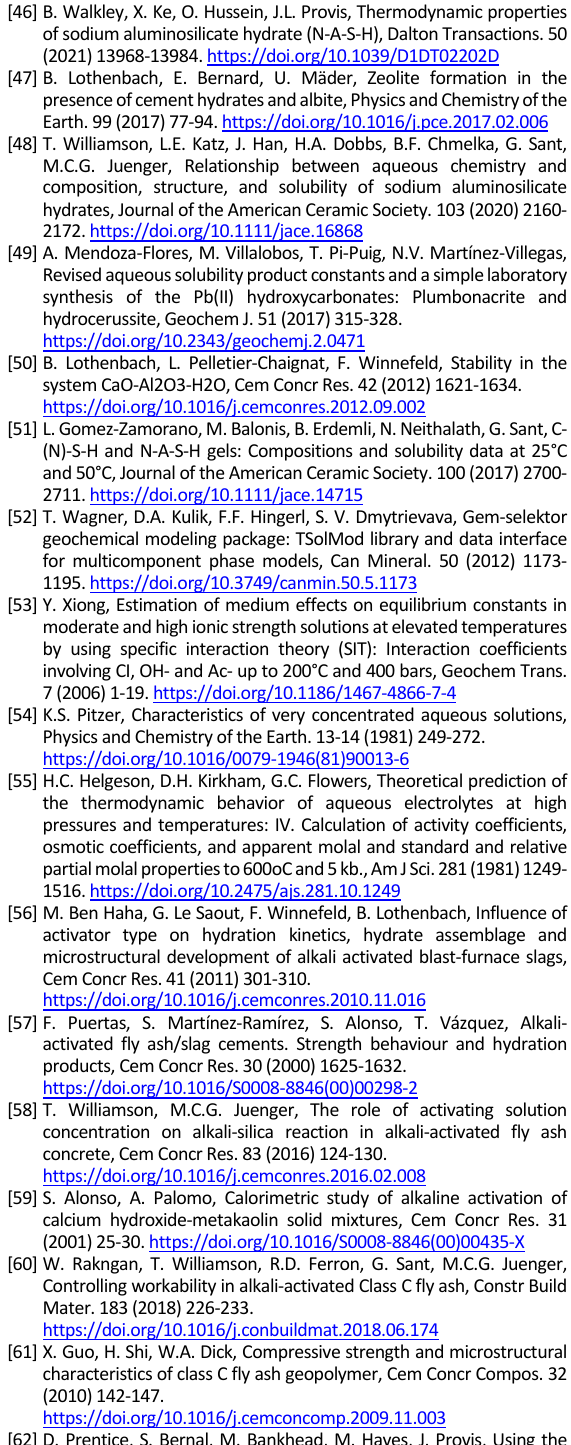
Comparison between freeze ‐ drying (F ‐ drying), D ‐ drying, P ‐ drying and oven ‐ drying methods, Cem Concr Res. 36 (2006) 634 ‐